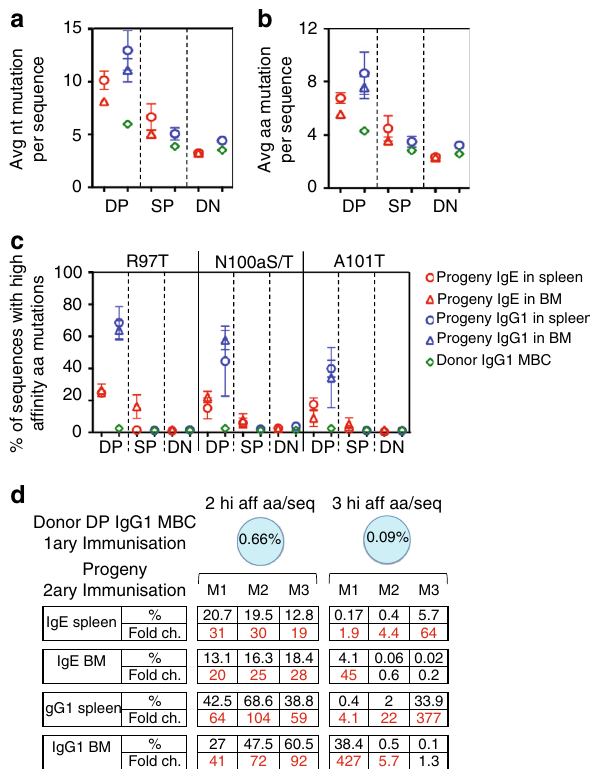
Fig. 3 PC derived from DP IgG1 MBC are enriched in high af fi nity mutations. VDJ nucleotide (nt) and amino acid (aa) sequences were compared between IgG1 MBC subsets and their IgE and IgG1 progeny cells. IgG1 MBC subsets were puri fi ed from 10 weeks OVA-PEP1 immunised TBmc mice, and transferred together with CD4 memory T cells into Rag1 KO recipient mice. The recipient mice were immunised with OVA-PEP1. Spleen and bone marrow (BM) of the recipient mice were collected 2 weeks later. The VDJ repertoires of parental IgG1 MBC subsets and their IgG1 and IgE progeny were analysed using next generation sequencing. a , b Average number of nt a and aa b mutations per sequence. c Percentage of sequences containing R97T, N100aS/T or A101T high af fi nity CDR3 mutations. a – c Data are average ± SEM of three mice per group. d Enrichment in the percentage of CDR3 sequences containing 2 or 3 high af fi nity aa per sequence (hi aff aa/seq) in the IgE and IgG1 progeny of DP IgG1 MBC (M1, M2 and M3 indicate three recipient mice). Data are representative of two independent CD73 + PDL2 + IgG1 MBC to differentiate into plasma cells 25 . No